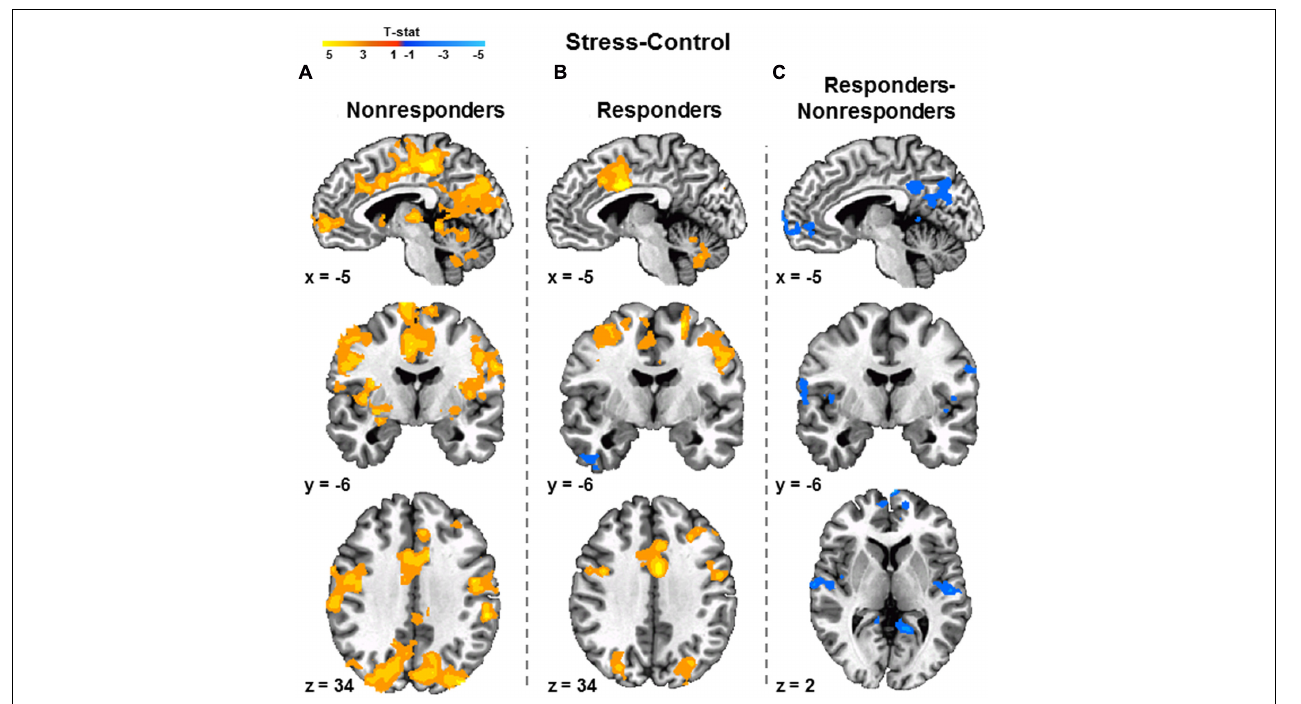
FIGURE 4 | Relationship between cortisol release and fMRI signal during the MIST. Differential activity (Stress vs. Control) associated with cortisol Non-responders ( n = 30) (A) and Responders ( n = 22) (B) . A two-sample t -test revealed Non-responders demonstrated greater differential ventromedial prefrontal cortex and posterior cingulate cortex activity than Responders (C) . Images are FWE corrected at p < 0.05 and presented in radiologic